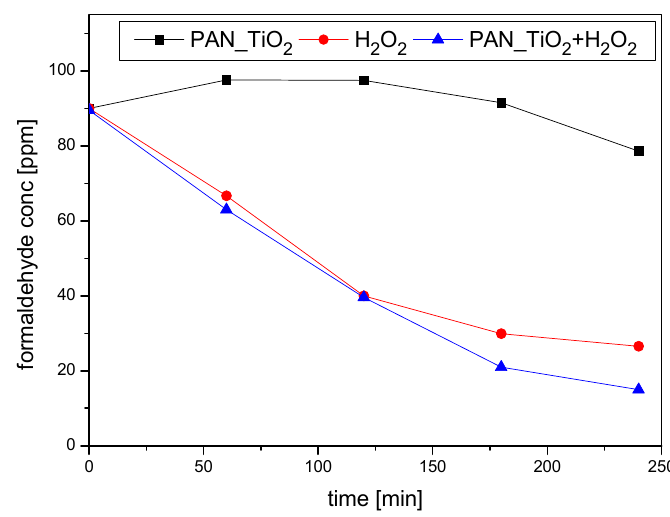
Figure 6. Formaldehyde concentration during photocatalytic experiment with and without added H 2 O 2 (400 ppm). The maximum standard deviation of the experimental points was 1.9 ppm.